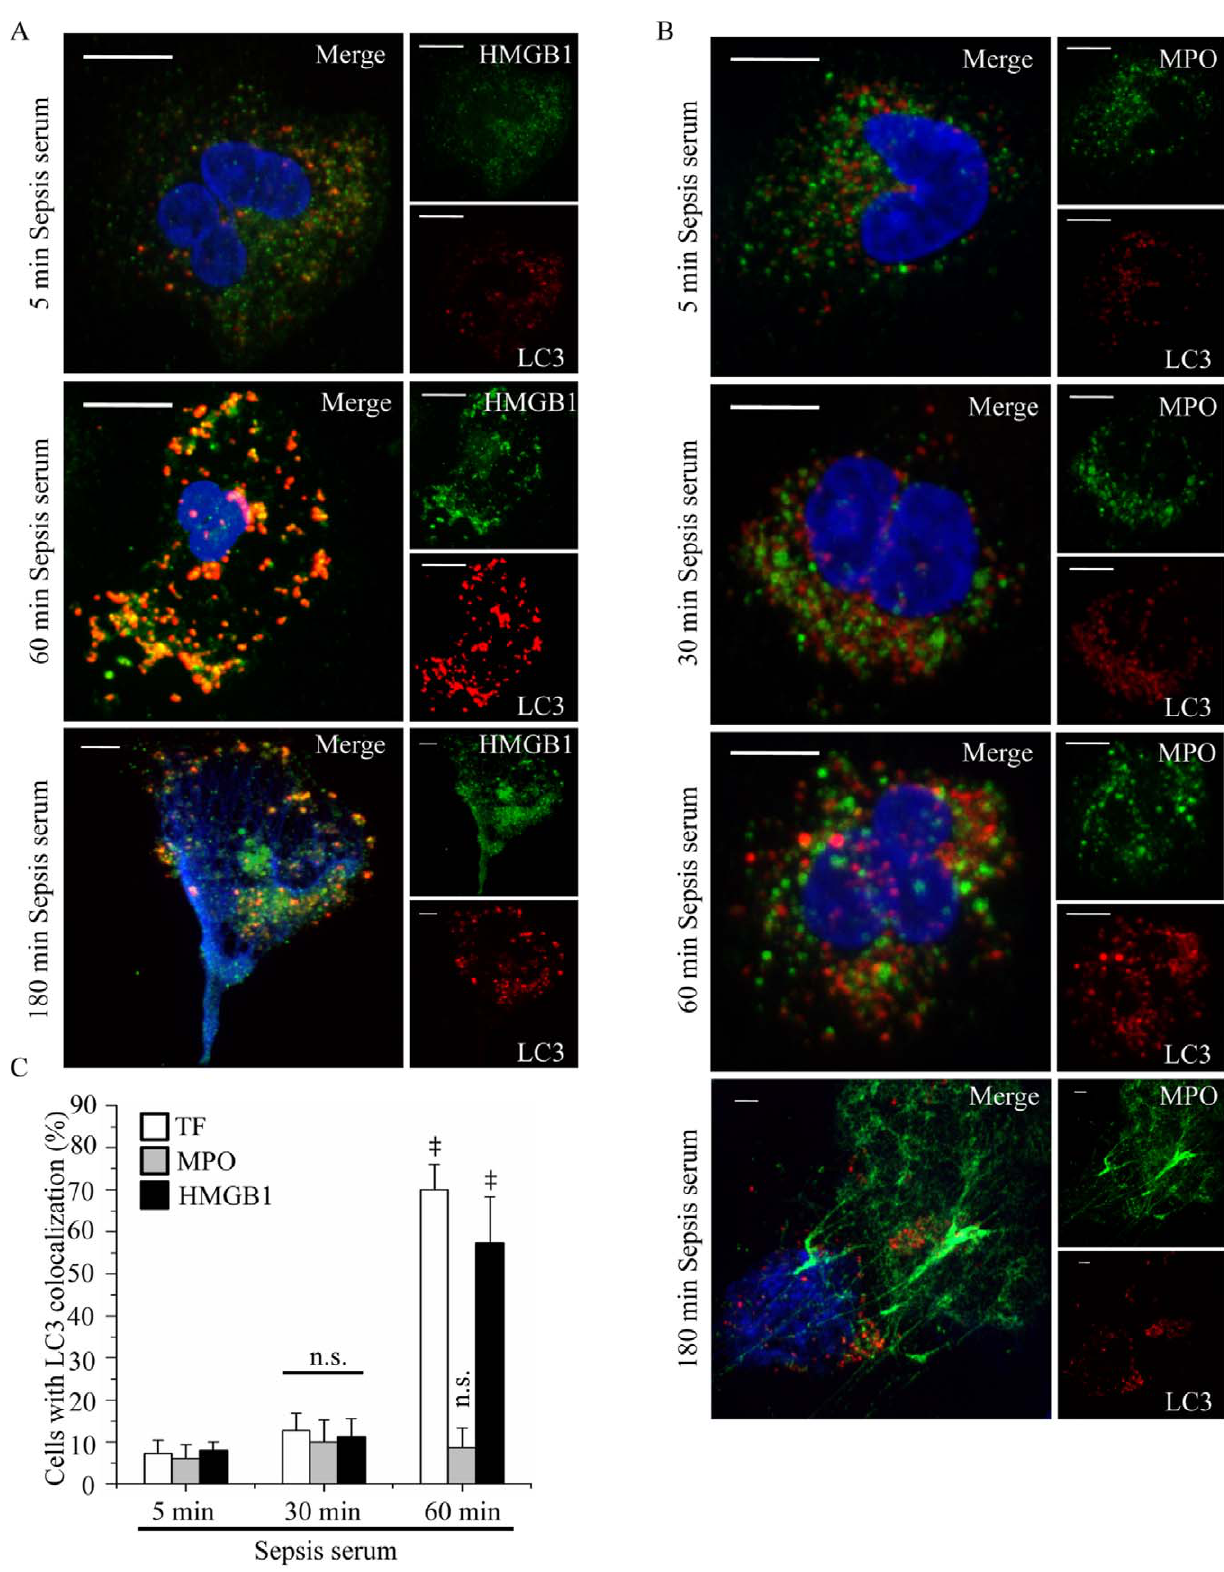
Figure 7. HMGB1, but not MPO, is colocalized with LC3B in control neutrophils treated with sepsis serum. Control neutrophils were treated at different time points with sepsis serum and the colocalization of HMGB1 (A) and MPO (B) with LC3B-coated structures was assessed by confocal microscopy (z stack analysis, 0.3 m m per plane). (DNA labeled with DAPI; blue, anti-LC3B mAb; red, anti-HMGB1; green in A, anti-MPO; green in B) (original magnification 1000 6 ). One out of three independent experiments is shown in A–B. Scale bar represents 5 m M. (C) Percentage of